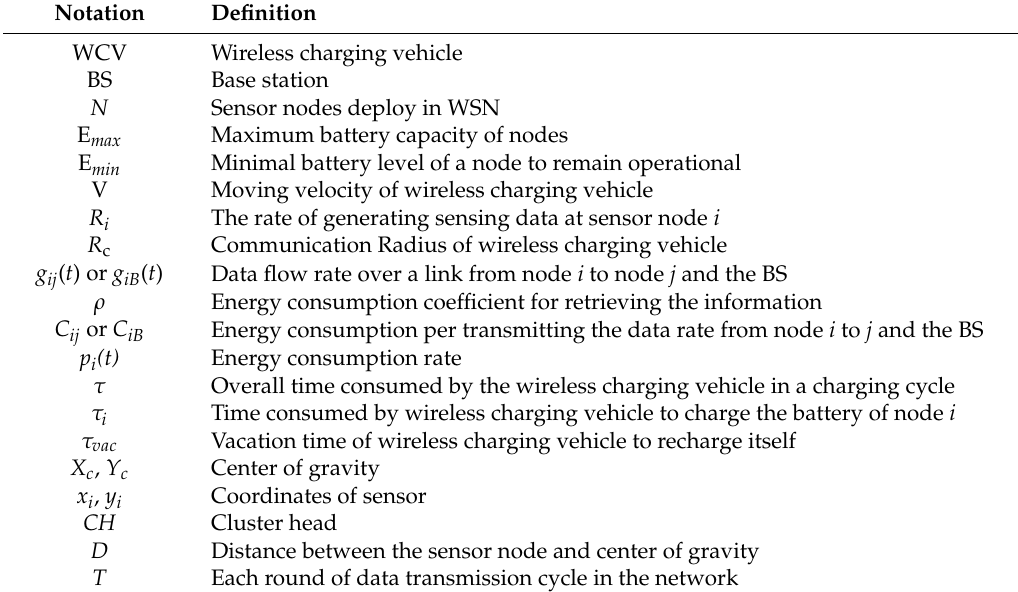
Table 1. The notations used in the